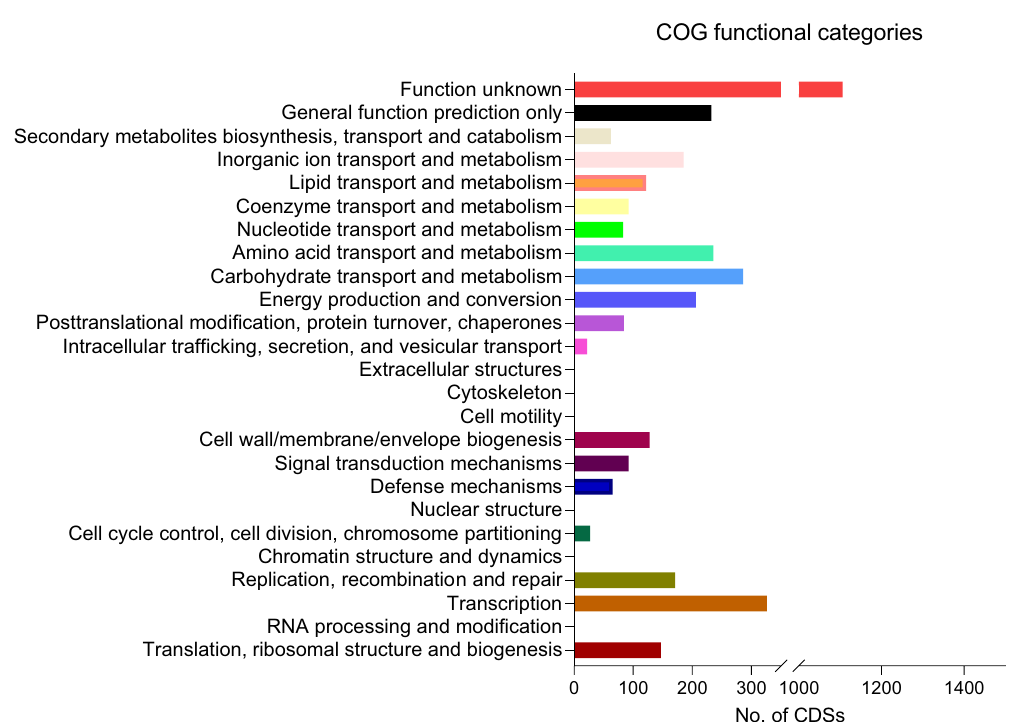
Figure 2. The cluster of orthologous groups (COG) classification of putative proteins in the whole genome sequence of strain AK-R2A1-2 T